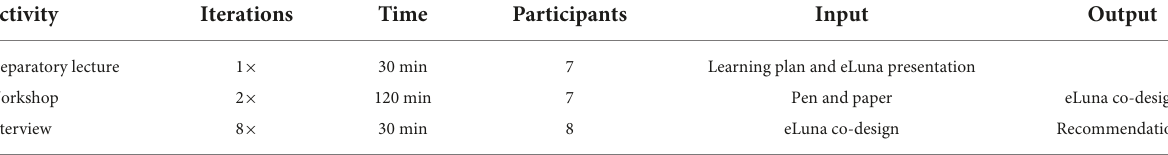
TABLE 3 Preparation, workshop, and interview